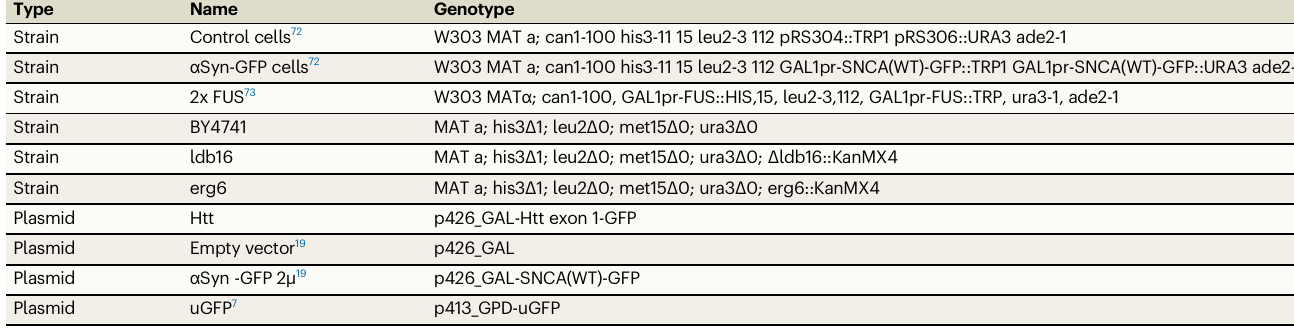
Table 1 | Description of strains and plasmids used